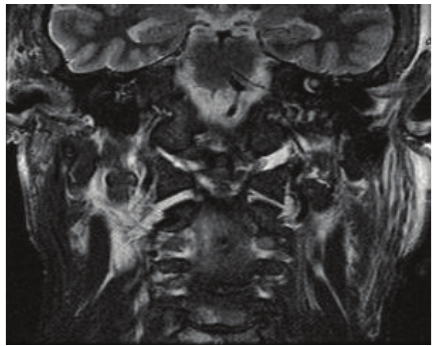
Figure 8: Coronal T2 weighted MRI showing occiput-C1 displace- ment, C1-C2 displacement, and soft tissue edema in the pericervical spine